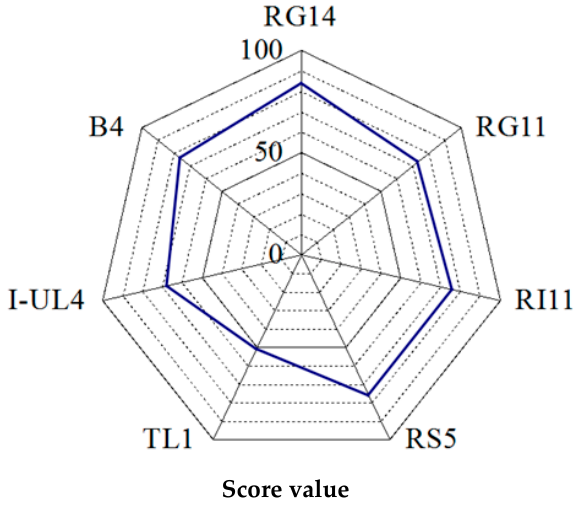
Figure 2. Rating of extracellular hydrolytic enzyme activities of Lactobacillus plantarum strains